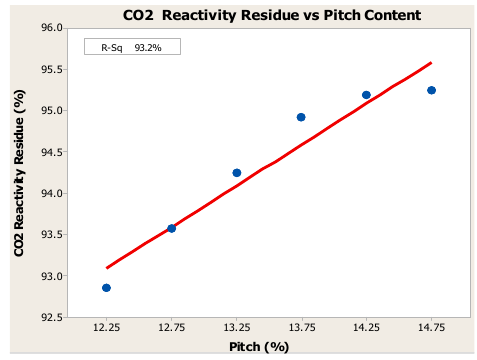
Figure 5. CO 2 reactivity residue vs. pitch.